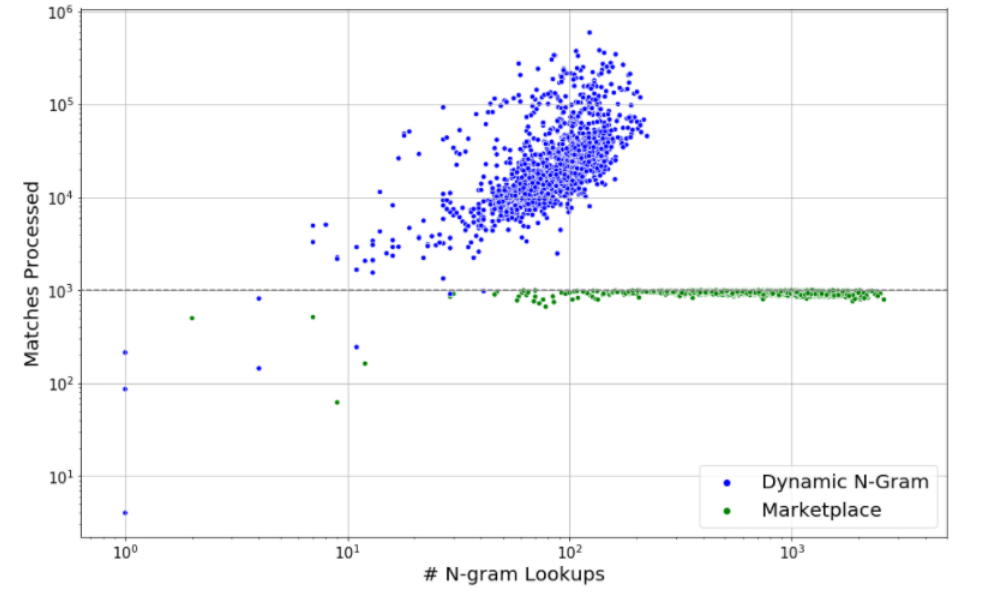
Figure 8. Comparison of fingerprint lookup strategy between marketplace and dynamic n-gram systems. Each point shows the number of fingerprint lookups and number of database matches processed for a single test